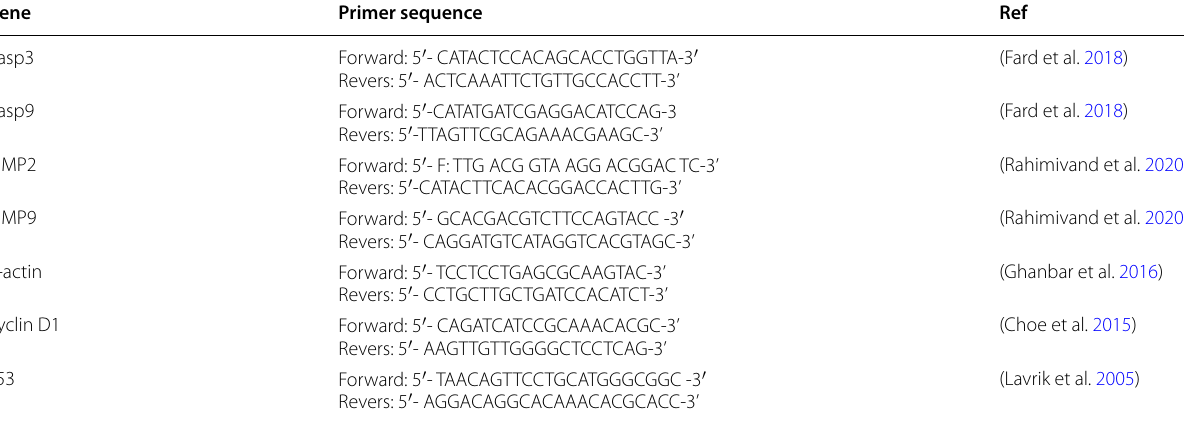
Table 1 Primer sequence designated for the RT-PCR Gene Primer